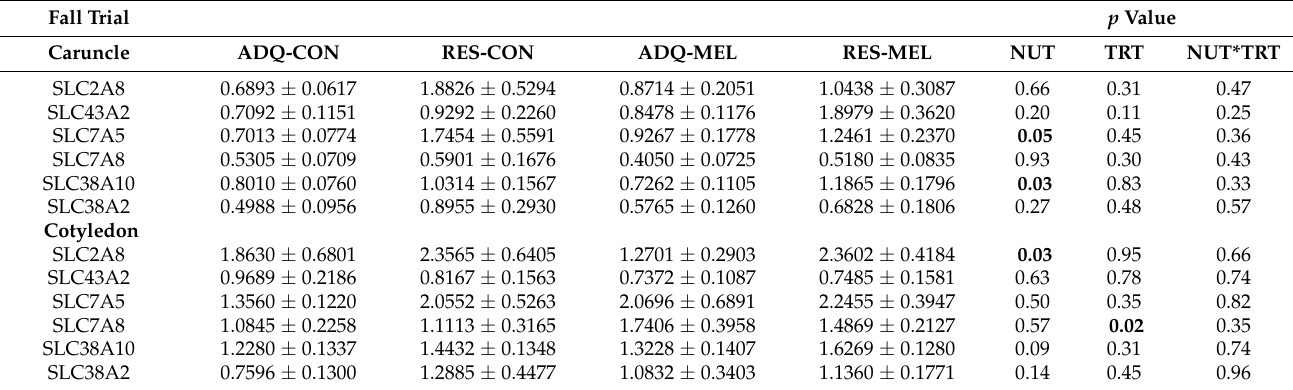
Table 4. Transcript abundance of nutrient transporters in caruncle and cotyledon tissue in the fall